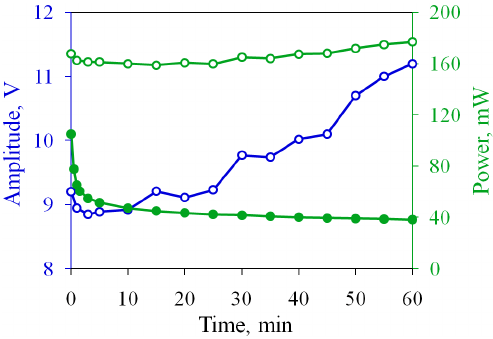
Figure 6. Time dependence of the amplitude of SP pulses and power consumption in the long-term test. Filled and open circles correspond to the normal and current stabilization regimes, respectively.